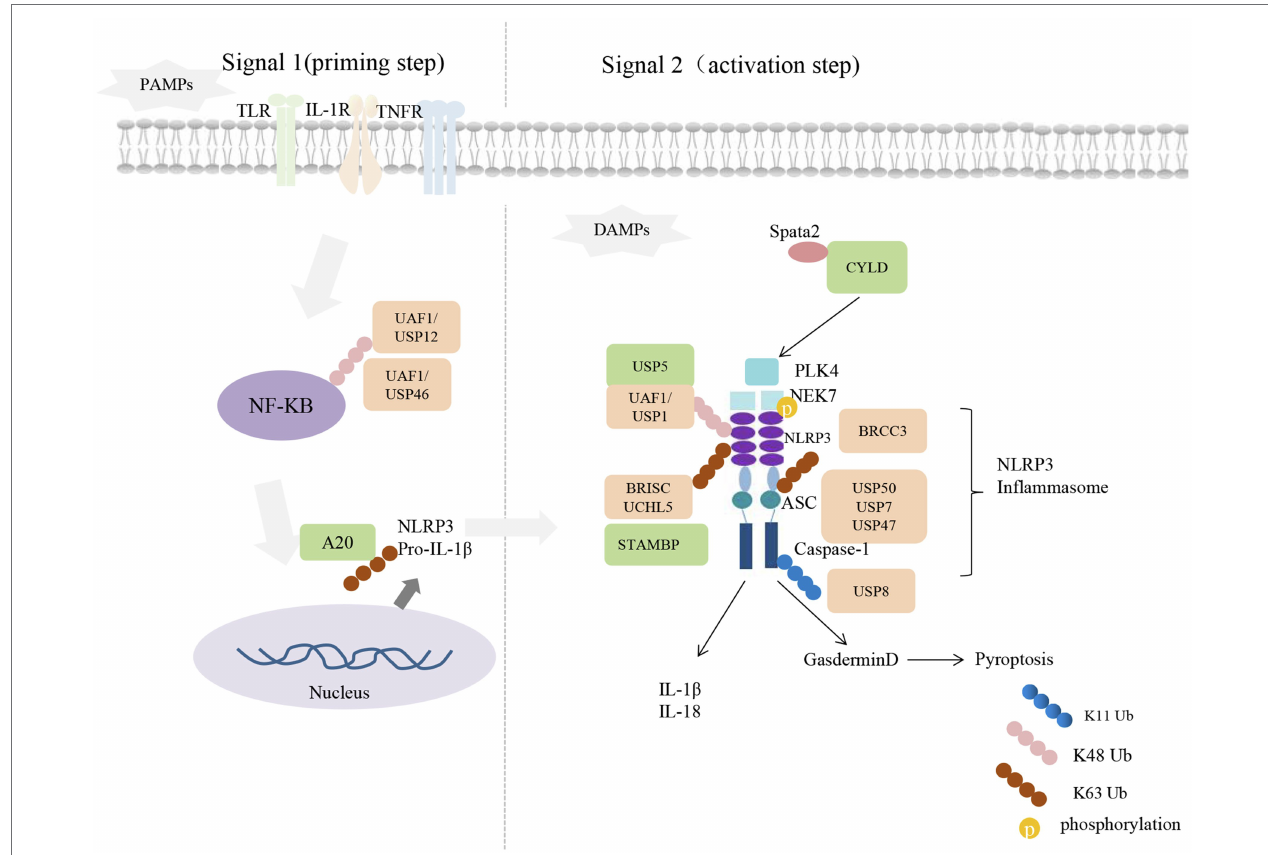
FIGURE 1 | Deubiquitylating enzymes in the activation of NLR Family pyrin domain containing 3 (NLRP3) inflammasome. The expression of NLRP3 and pro-IL-1 β induced by NF- κ B as the priming signal of NLRP3 inflammasome activation. Signal 2: with the stimulate of danger-associated molecular patterns (DAMPs), NEK7 binds with NLRP3, promoting its oligomerization and activation completely. Activated NLRP3 interacts with apoptosis-associated speck-like protein (ASC)